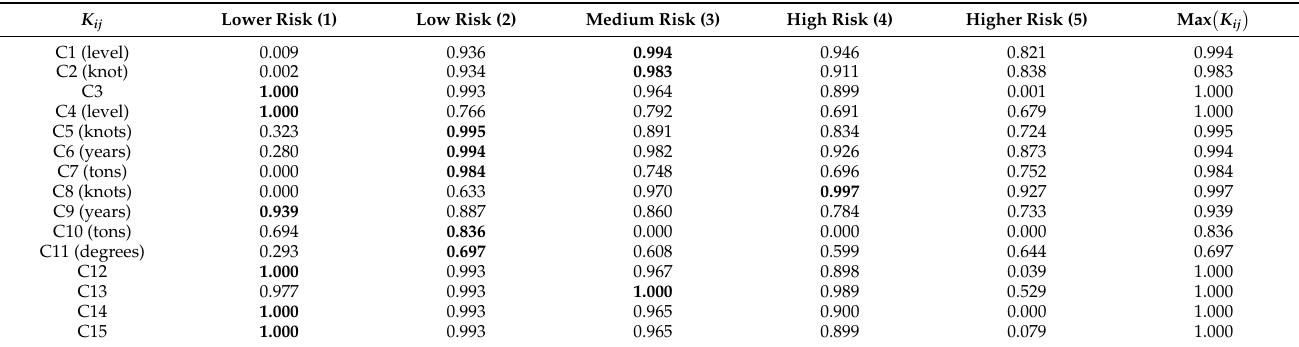
Table 12. Relevance of indicator data of “X” to each level of the cloud model. (The bold value in the table represents the final risk level of the indicator.).